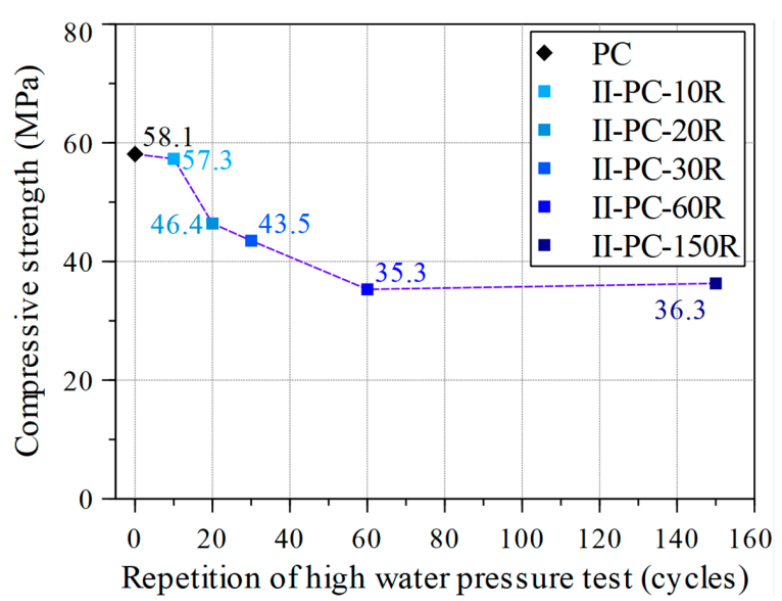
Figure 10. Compressive strength versus the number of repeated cycles of high water pressure.